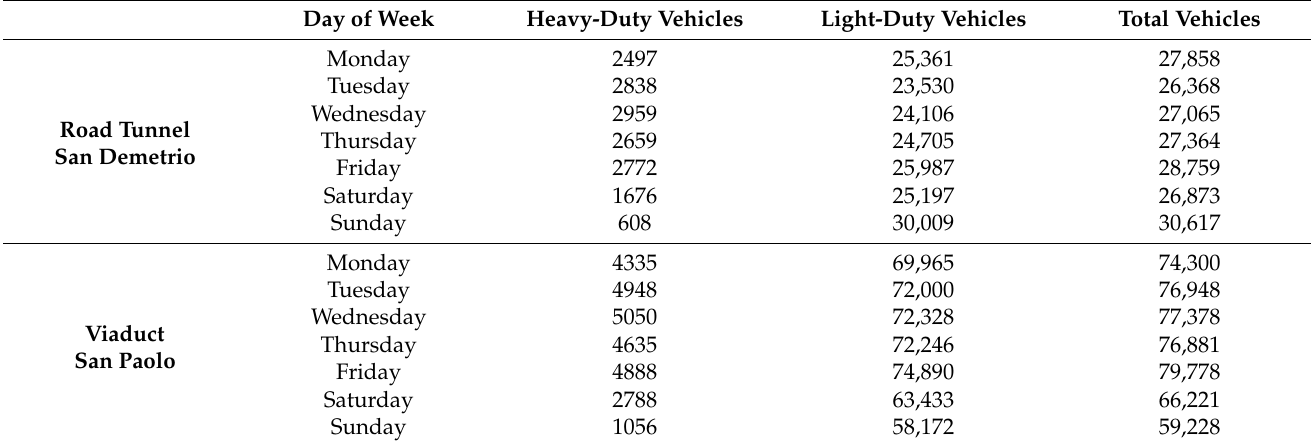
Table 5. Total number of vehicles for the three months under investigation and further classified in terms of heavy-duty or light-duty vehicles, for road tunnel and for Viaduct San Paolo in the trimester April–June